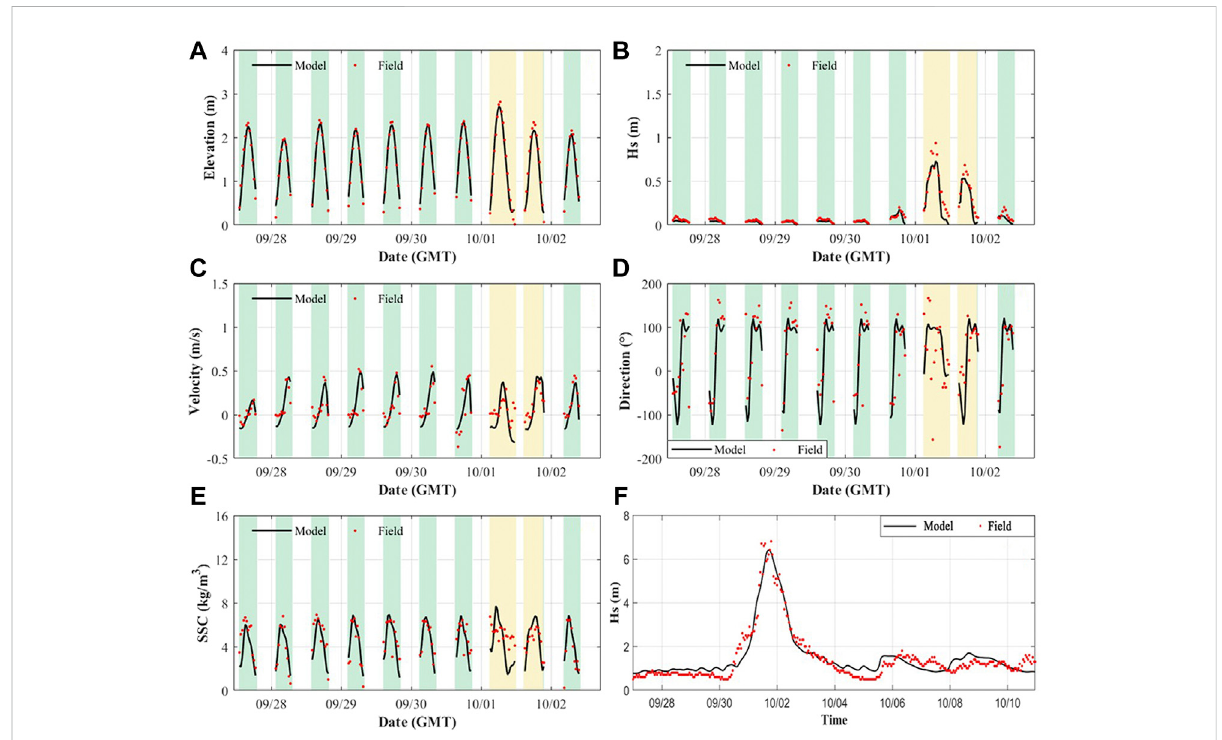
FIGURE 3 Model validation ofsea surfacelevel,currents,signi fi cantwaveheight, andSSC. (A – E) Station S1intheAndongShoal (F) near ZhoushanIslands. Thegreenbackgroundrepresentstheprobeswereunderwater,andtheyellowbackgroundrepresentsthatthespeedsoflocalwindwerelargerthan 10